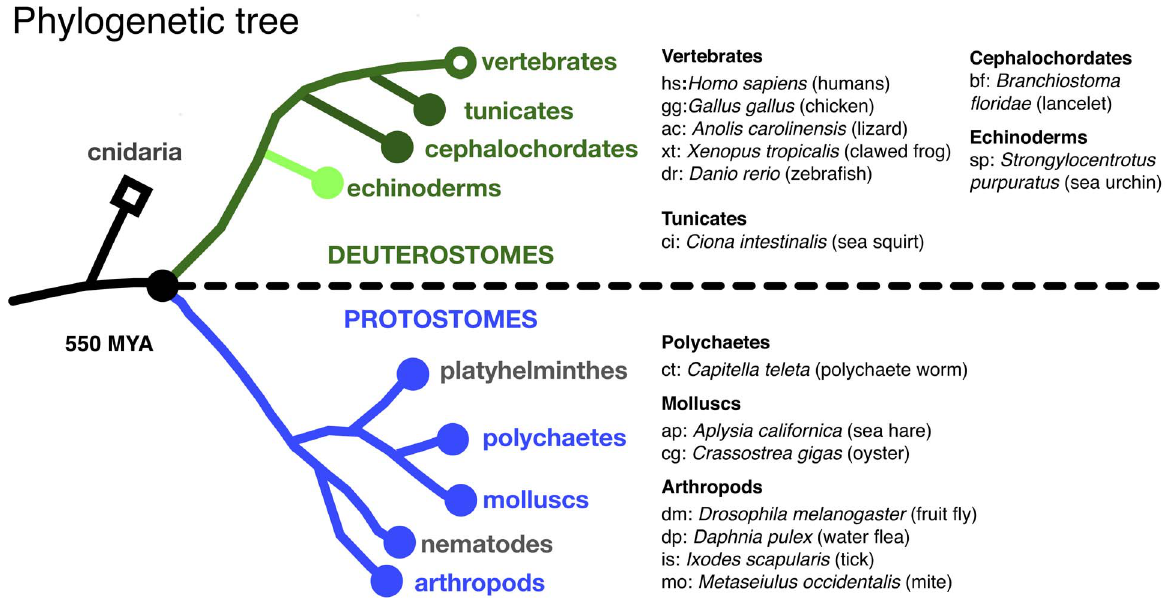
Figure 3. Phylogenetic tree for RGK protein orthologs. Phylogenetic tree layout was adapted from Yau and Hardie [40]. The deuterostome branch is labeled in green with dark green representing the phylum chordata. Tunicates and cephalochordates are subdivisions within this phylum with vertebrates representing the major group. Echinoderms (e.g., starfish, sea urchins, sea cucumbers) represent the second largest grouping of deuterostomes and are labeled in light green. The protostome branch is depicted below the dotted line in blue. Major phyla for which RGK protein orthologs/homologs were identified are presented in blue and the others in gray. Organisms with two letter abbreviation and common name (in parentheses) are depicted on the right.